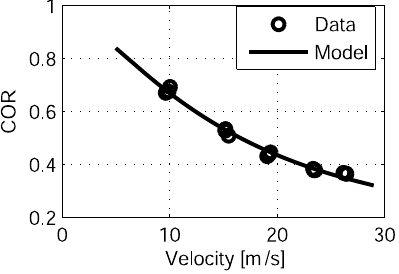
Fig. 10. COR data points used to fi t parameters β 3 to β 5 along with least squares fi t